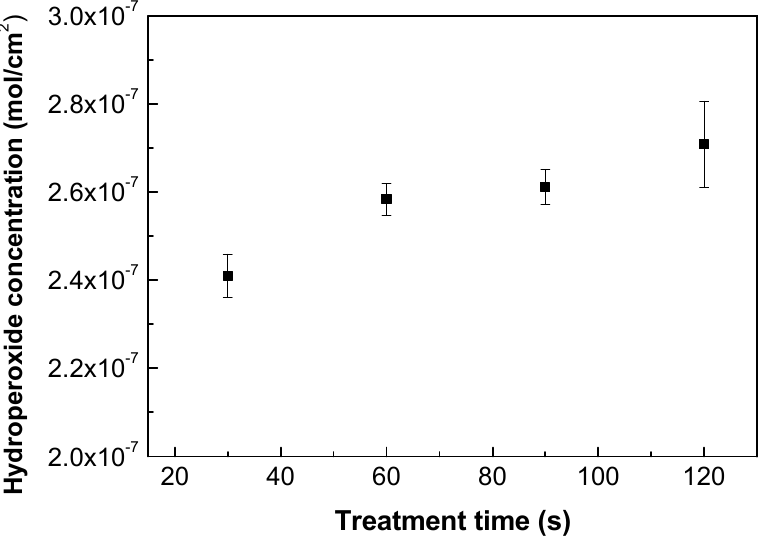
Figure 2. Hydroperoxide concentration vs. treatment time of plasma-treated PLA samples.